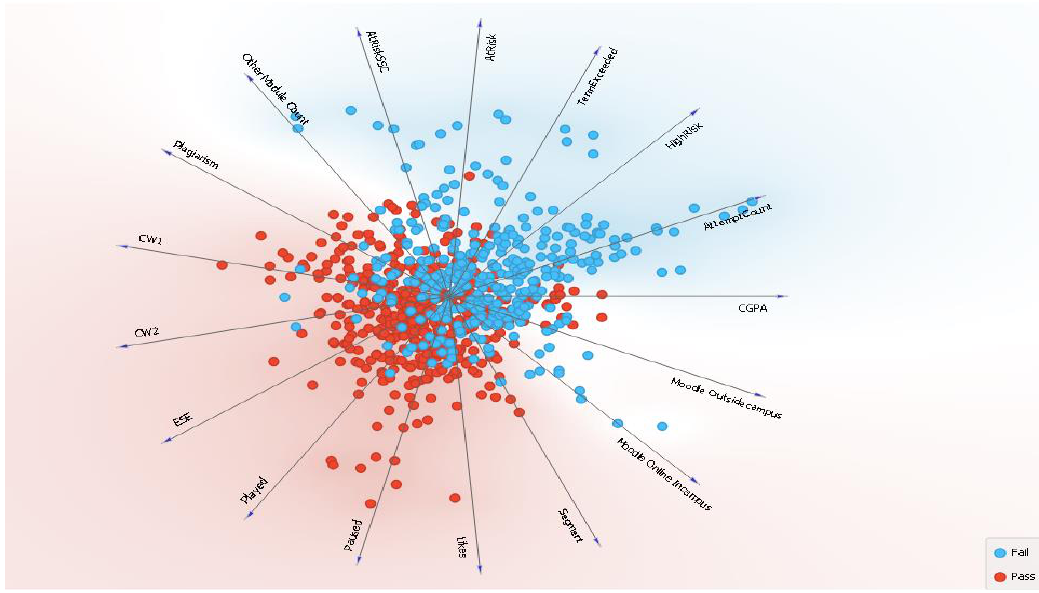
Figure 5. Multivariate projection. Figure 6. Multivariate